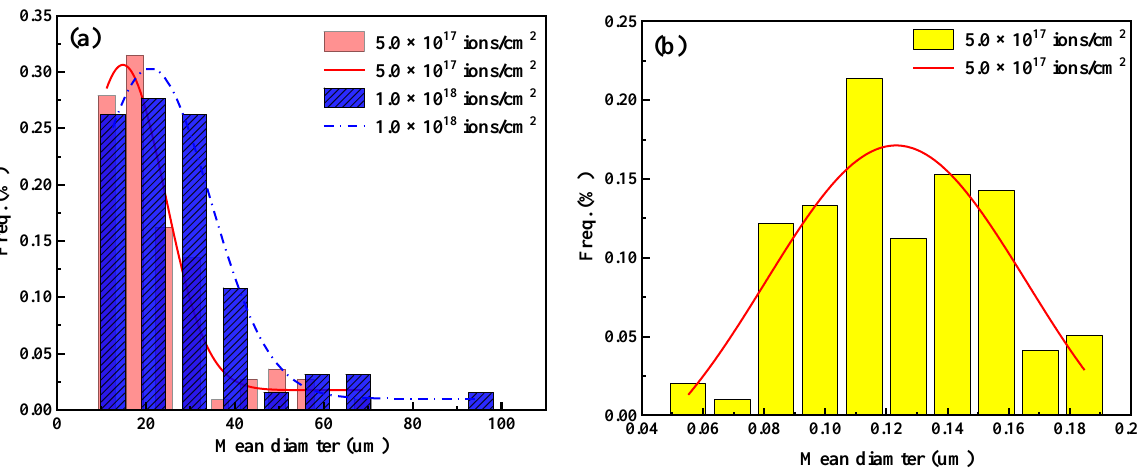
Figure 3. Size distribution of ( a ) blisters on the surface of the sample with 5.0 × 10 17 ions/cm 2 and 1.0 × 10 18 ions/cm 2 and ( b ) nano-sized blisters on the surface of the sample with 5.0 × 10 17 ions/cm 2 .